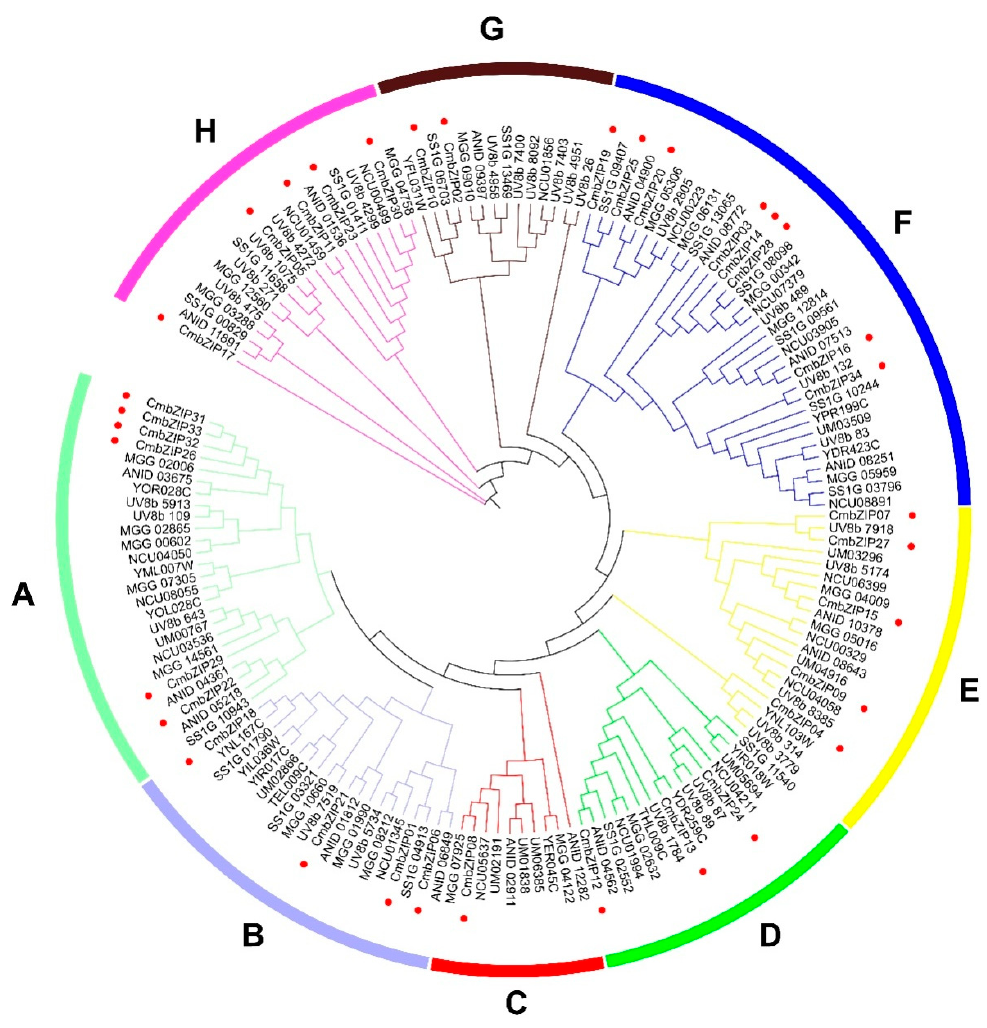
Figure 2. Phylogenetic analysis of bZIP proteins from eight fungi. The maximum-likelihood trees were constructed based on 159 full-length protein sequences. The phylogenetic tree was constructed using IQ-TREE multicore version 1.6.12 and the bootstrap test carried out with 1000 iterations. The proteins are clustered into eight clades (A–H) indicated by colored branches. The CmbZIPs are denoted by red circles. The sequences were collected from organisms as follows: Cm, Coniothyrium minitans ; MGG, Magnaporthe oryzae ; ANID, Aspergillus nidulans ; UV8b, Ustilaginoidea virens ; NCU, Neurospora crassa ; UM; Ustilago maydis ; and SS1G; Sclerotinia sclerotiorum ; the rest proteins were from Saccharomyces cerevisiae